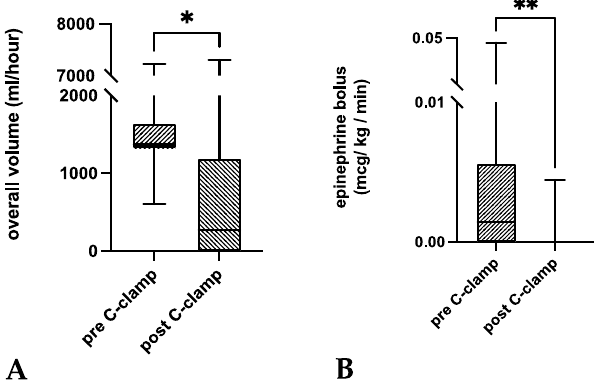
Figure 4. Box plots of the pairwise comparisons of medians before and after C-clamp application for the ( A ) overall volume administered per hour and the ( B ) epinephrine bolus. Both the volume substitution and epinephrine bolus administration significantly decreased within the first hour after C-clamp application ( p < 0.05). Box—interquartile range; bar—median. * p < 0.05; ** p < 0.01.